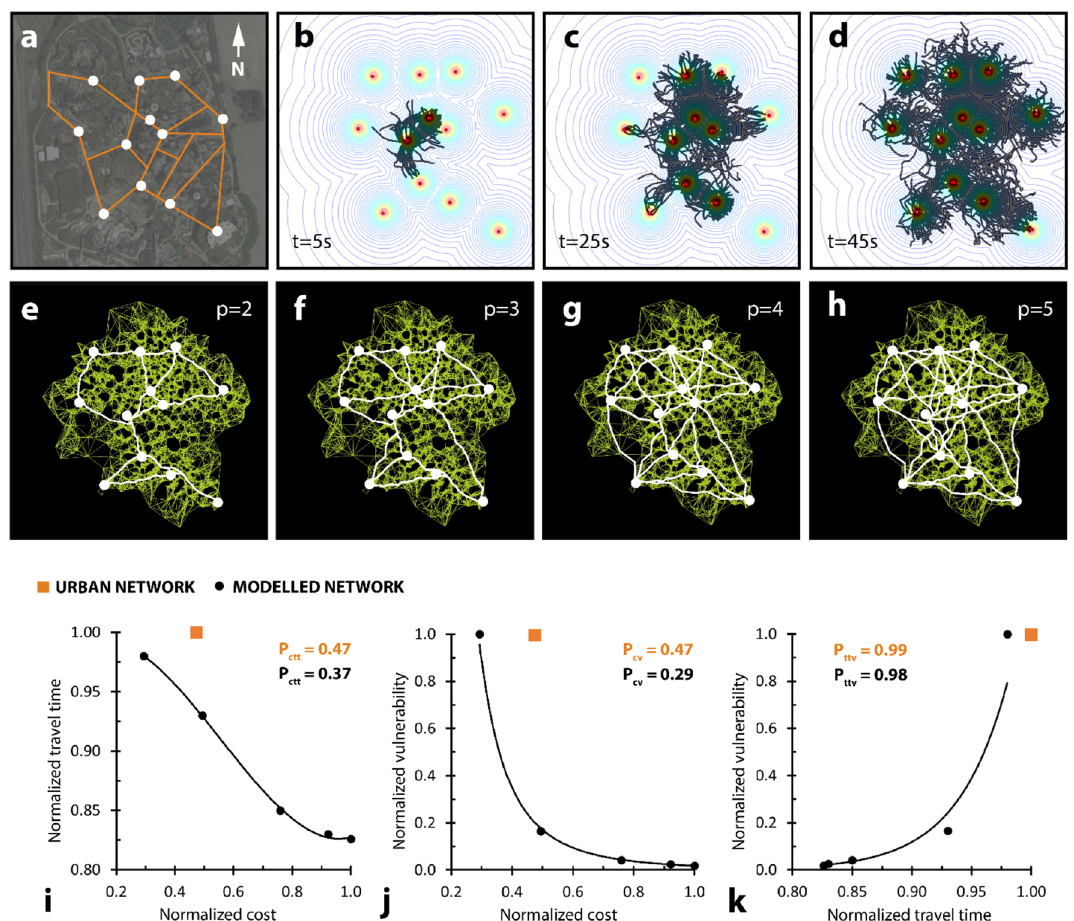
Figure 6. Built versus modelled amusement park network performance is varied. ( a ) Network to describe Canada’s Wonderland. Background image obtained from Google Maps. ( b – d ) Modelled growth to establish mesh to describe Canada’s Wonderland. ( e – h ) Different shortest-walk calculations for the same mesh, generated from ( d ), but with unique proximity coefficient values. ( i ) Plot relating network cost to travel time for both built (orange) and modelled (black) networks. Trendline is a third-order polynomial function. ( j ) Plot relating network cost to vulnerability for both built (orange) and modelled (black) networks. Trendline is a power function. ( k ) Plot relating network travel time to vulnerability for both built (orange) and modelled (black) networks. Trendline is an exponential function. All performance values normalized to the largest local value. Modelled performance values displayed on the plots represent performance for the closest modelled point to the built point (orange) along the